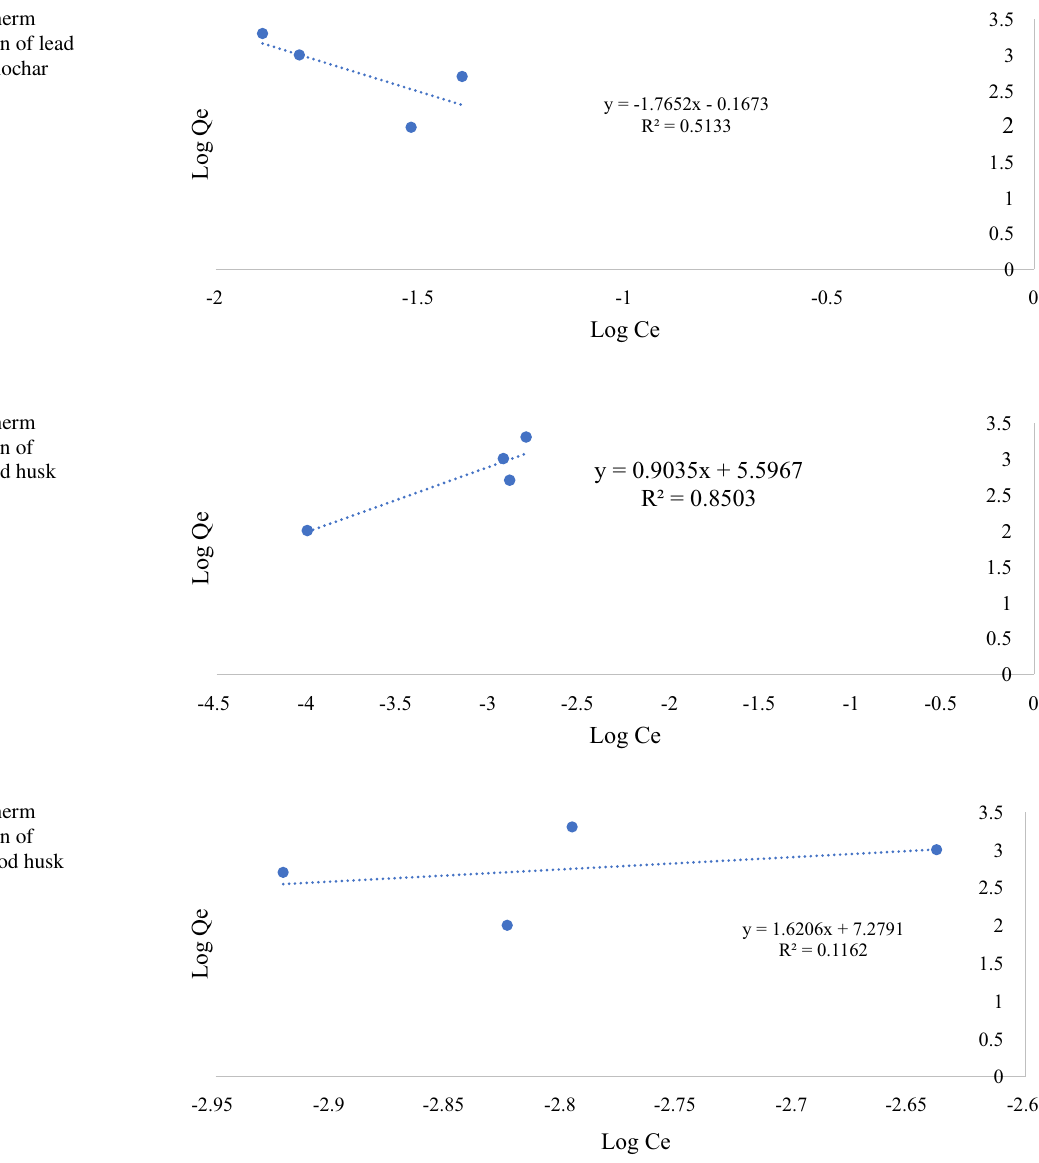
Fig. 6 Freundlich isotherm graph for the adsorption of cadmium onto cacao pod husk